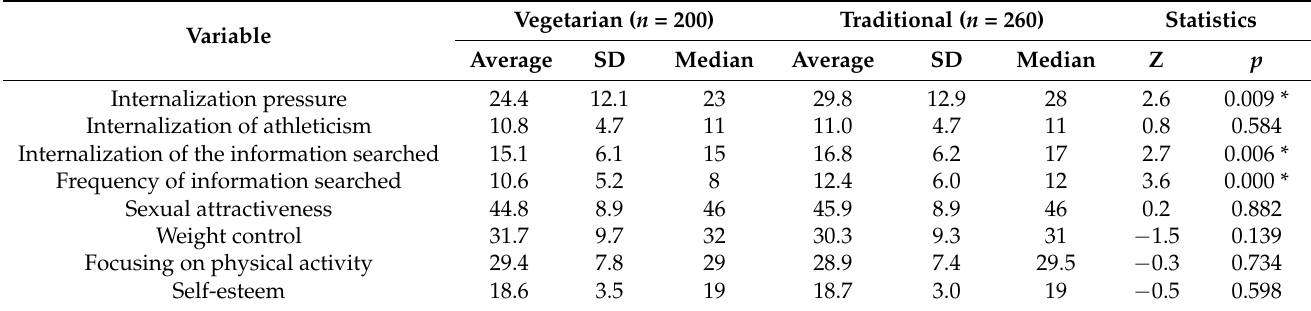
Table 3. Differences between traditional and vegetarian groups between studied factors ( n =